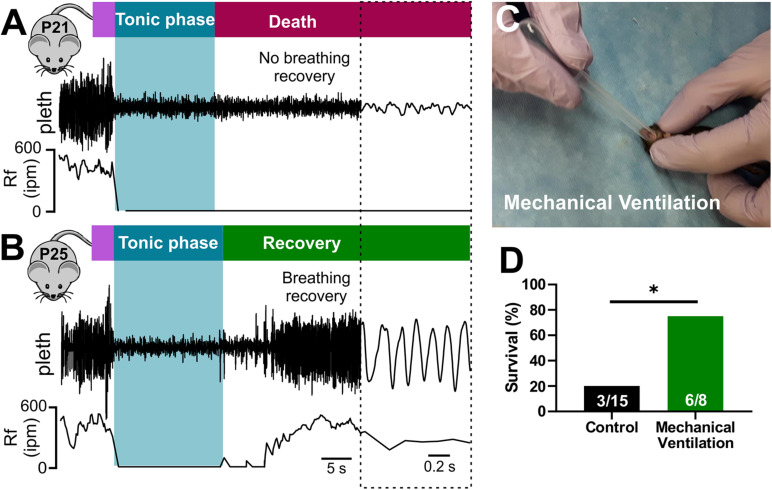
Seizure-induced respiratory arrest and sudden death in P20-21 D/+ mice. Plethysmography recordings during audiogenic seizures in a P21 D/+ mouse (A) and a P25 D/+ mouse (B). Behavioral seizure stages shown above traces. Wild running (purple) precedes a tonic phase (blue) followed by either death [red, (A)] or recovery [green, (B)]. (A) At the onset of the tonic phase of the audiogenic seizure, the P21 D/+ mouse ceases breathing (Rf near zero) and never recovers. (B) In a P25 D/+ mouse, breathing ceases during the tonic phase but recovers shortly after and the mouse survives. (C) Image of mechanical ventilation intervention to stimulate breathing after onset of an audiogenic seizure in P20-21 D/+ mice. (D) Bar chart of survival of control non-ventilated (black, n = 15) and ventilated (green, n = 8) P20-21 D/+ mice. Mechanical ventilation significantly improved rate of survival (*P < 0.05; one-sided Fisher’s exact test).